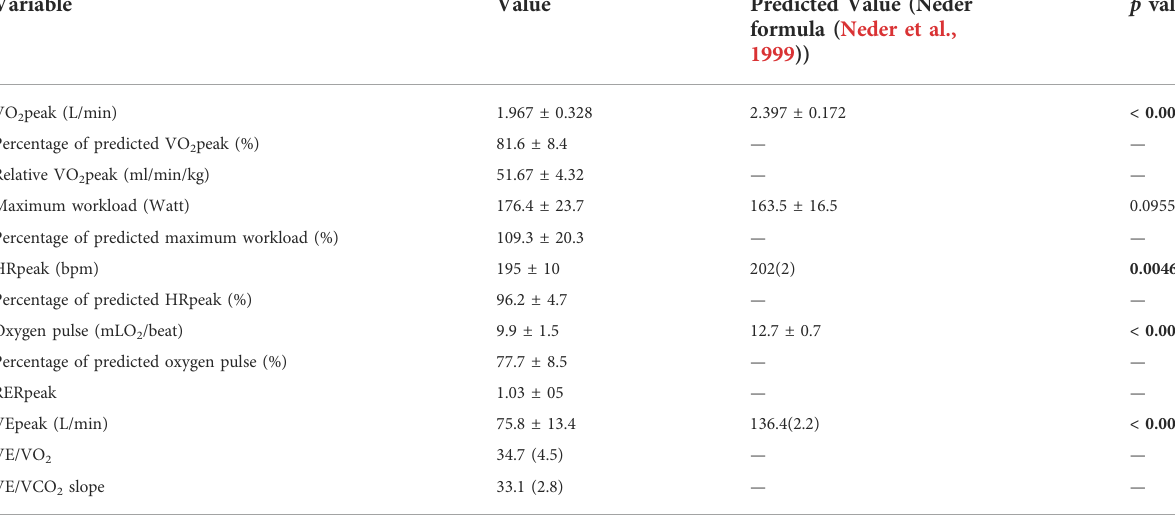
TABLE 2 Cardiopulmonary exercise testing variables and their predicted values of the athletes.